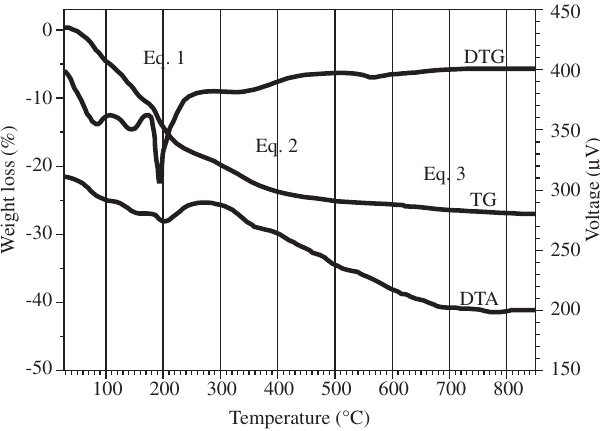
Figure 4. DTA, TG and DTG of CDHA-OCP- β -TCP biomaterial before sterilization.